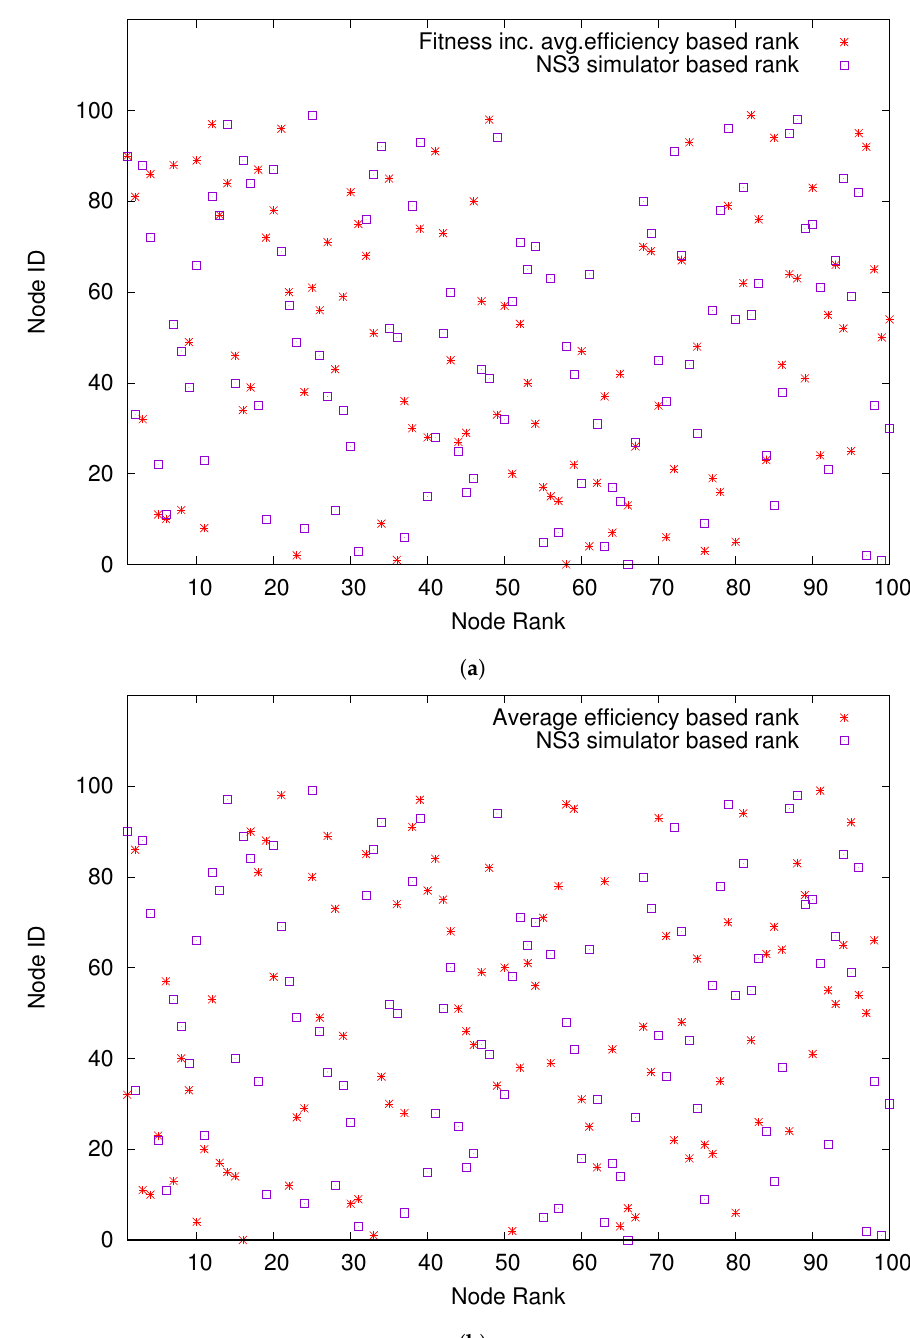
Figure A2. Node ranking comparison for random topology, when the fitness is distributed in a manner that does not correlate with the degree. ( a ) Fitness incorporated average efficiency-based ranking vs. NS3 simulator ranking. ( b ) Average efficiency-based ranking vs. NS3 simulator- based